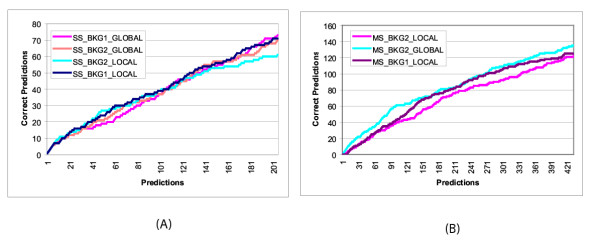
Effect of different parameter settings in Stubb, on prediction accuracy. (a: Single species Stubb, b: two-species Stubb.) The axes have the same interpretation as Figure 1a. Terminology in legend: "SS" – STUBBSS; "MS" – STUBBMS; "BKG1" and "BKG2": 1st and 2nd order background respectively; "LOCAL" and "GLOBAL": local and global background models respectively. (The axes are not to the same scale in (a) and (b).)